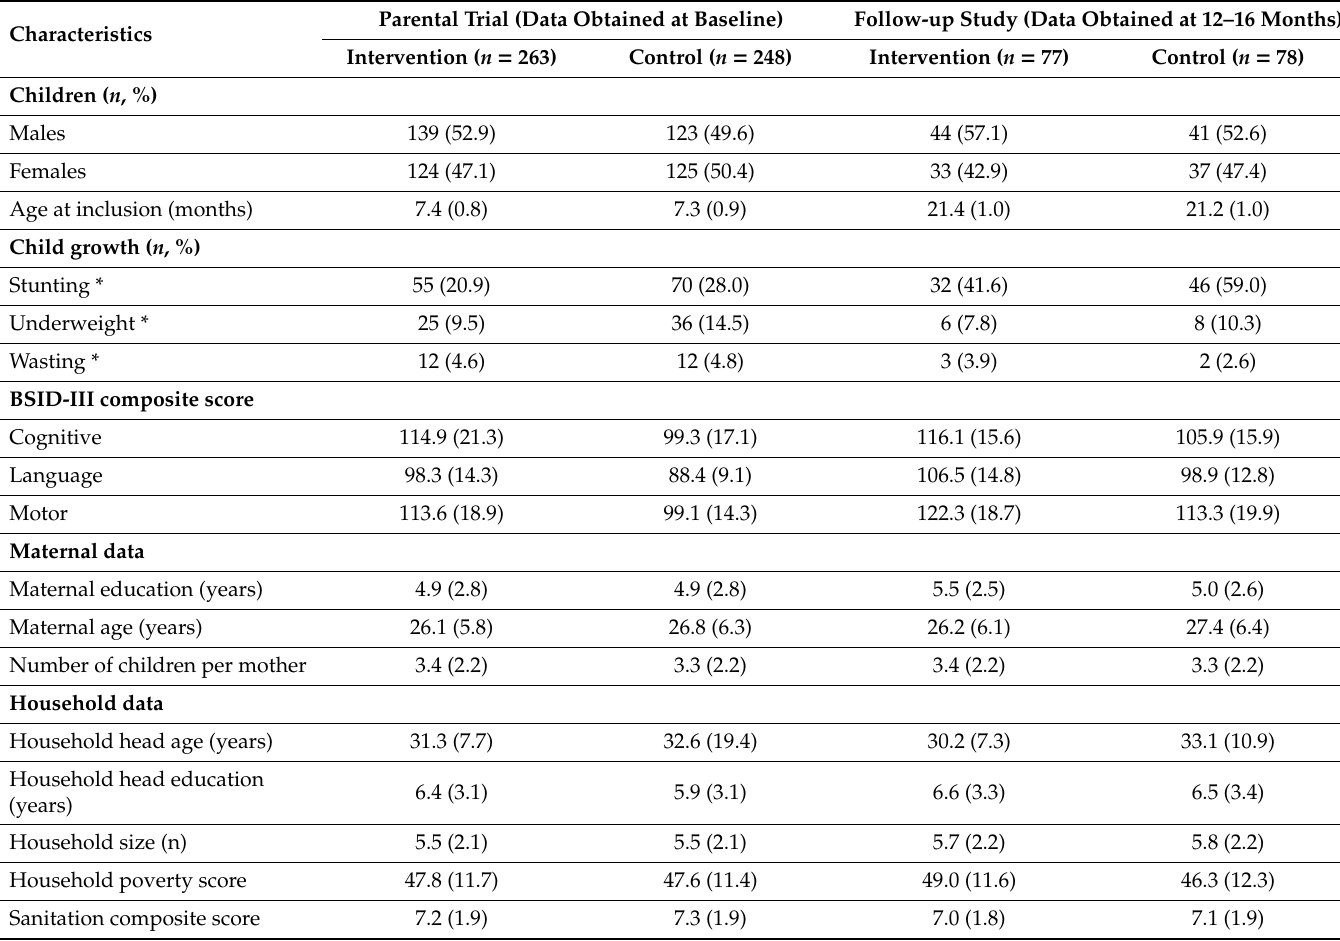
Table 1. Study population characteristics for the parental trial at baseline and at start of the follow-up study.